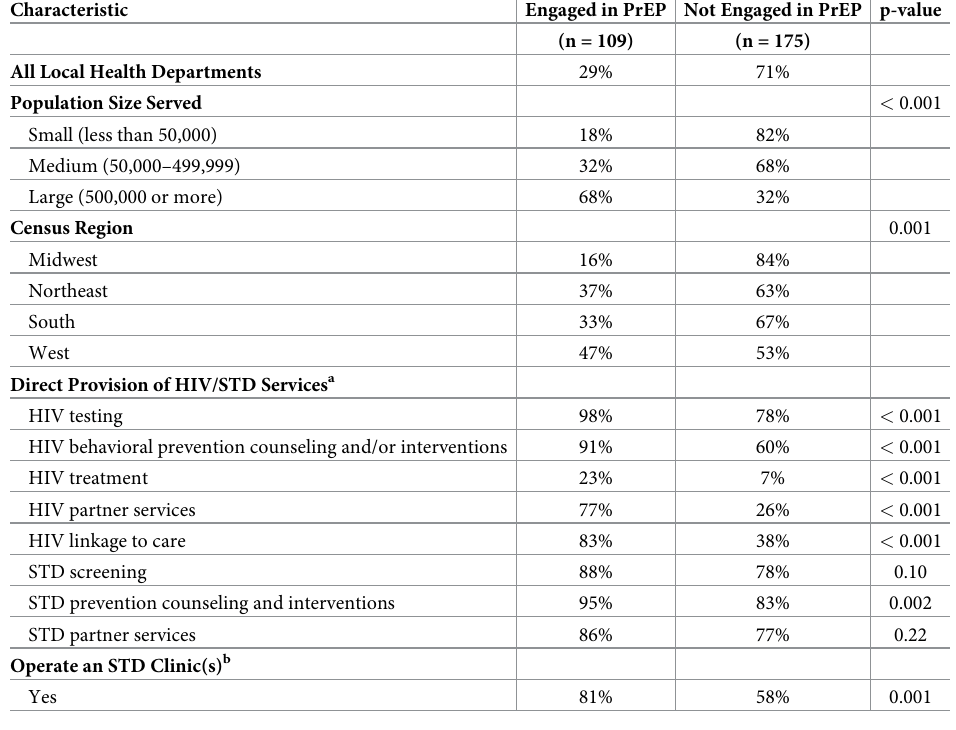
PrEP, preexposure prophylaxis; STD, sexually transmitted disease.